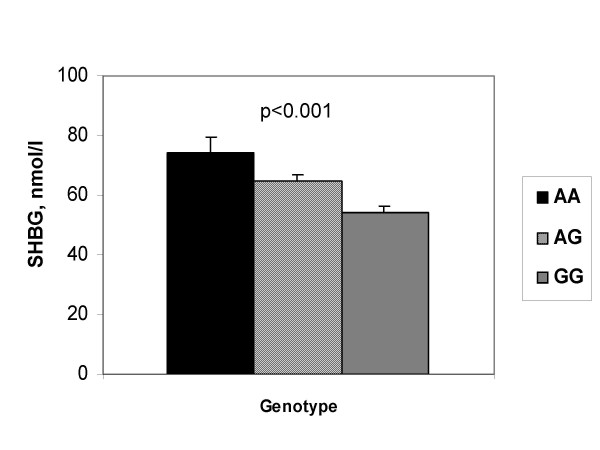
SHBG levels according to rs1799941 (mean and SEM of age- and weight-adjusted values).